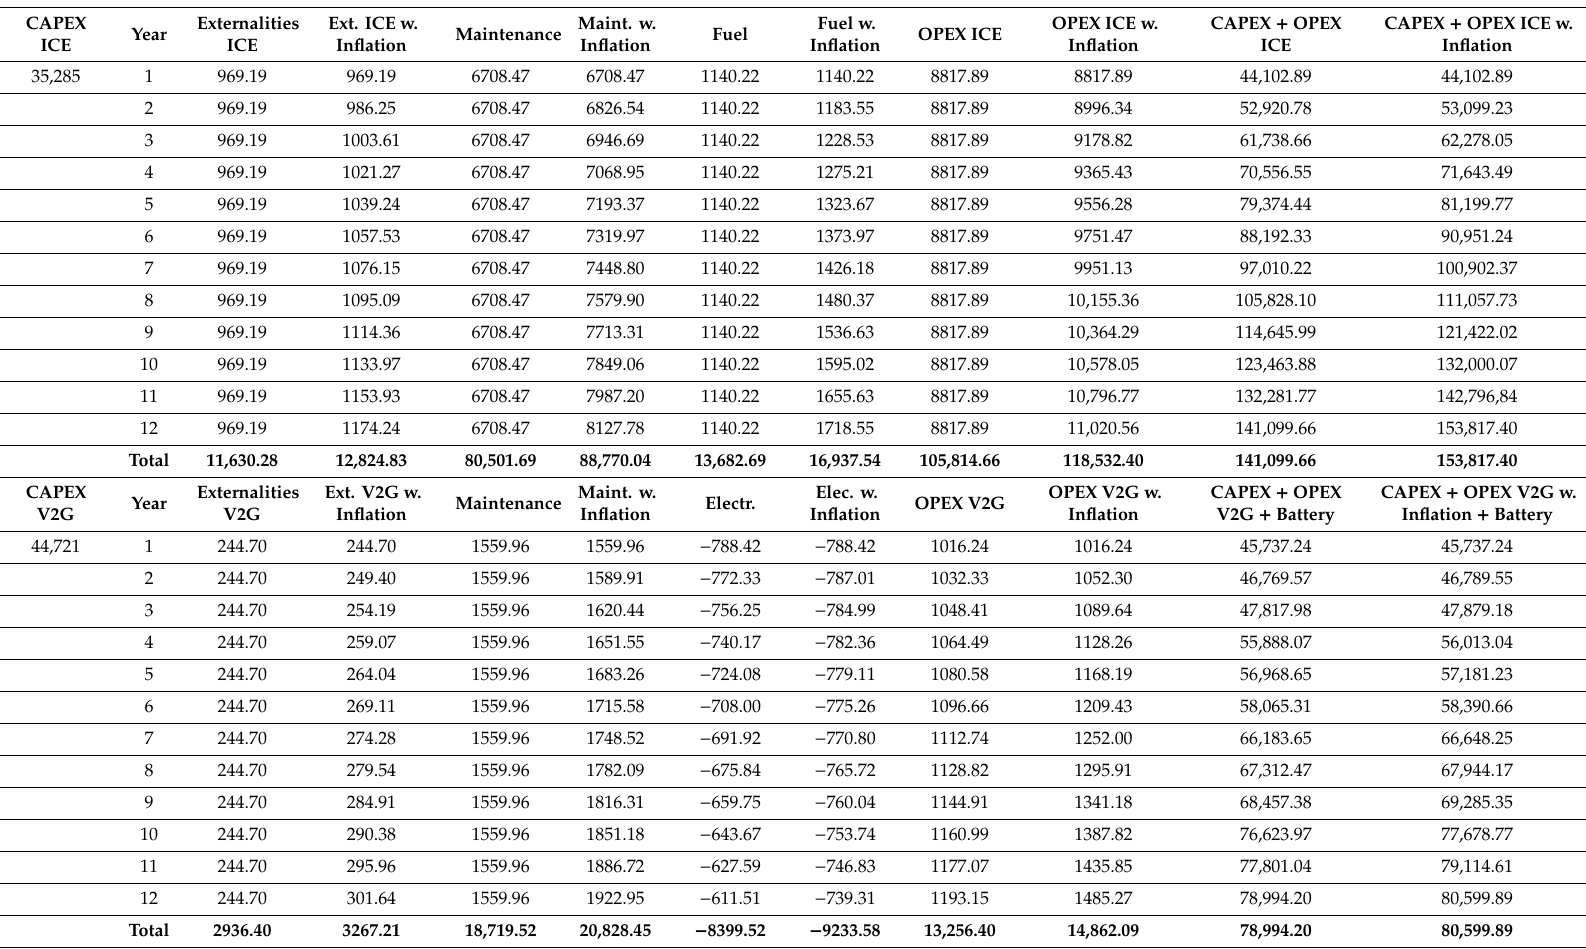
Table A2. Cumulative costs for ICE and V2G solutions, frequent drivers (figures are in